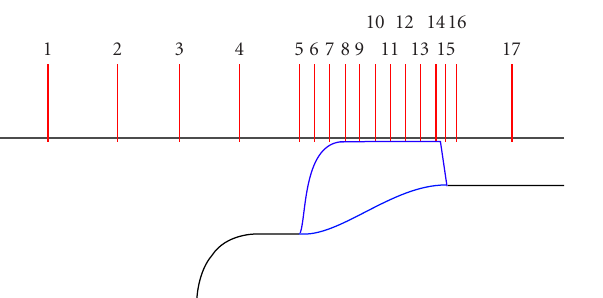
Figure 2: Position of the pressure taps along the shroud.